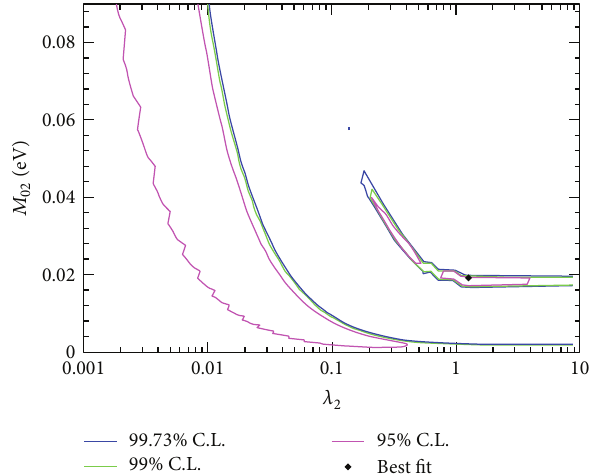
Figure 8: Exclusion curves in the parameter space MaVaN to 95 %, 99 %,and 99.73 %confidencelevels.Wecanseethattheeffectappears only in an island of values and does not exclude the standard model, which becomes dominant when the parameters tend to zero.